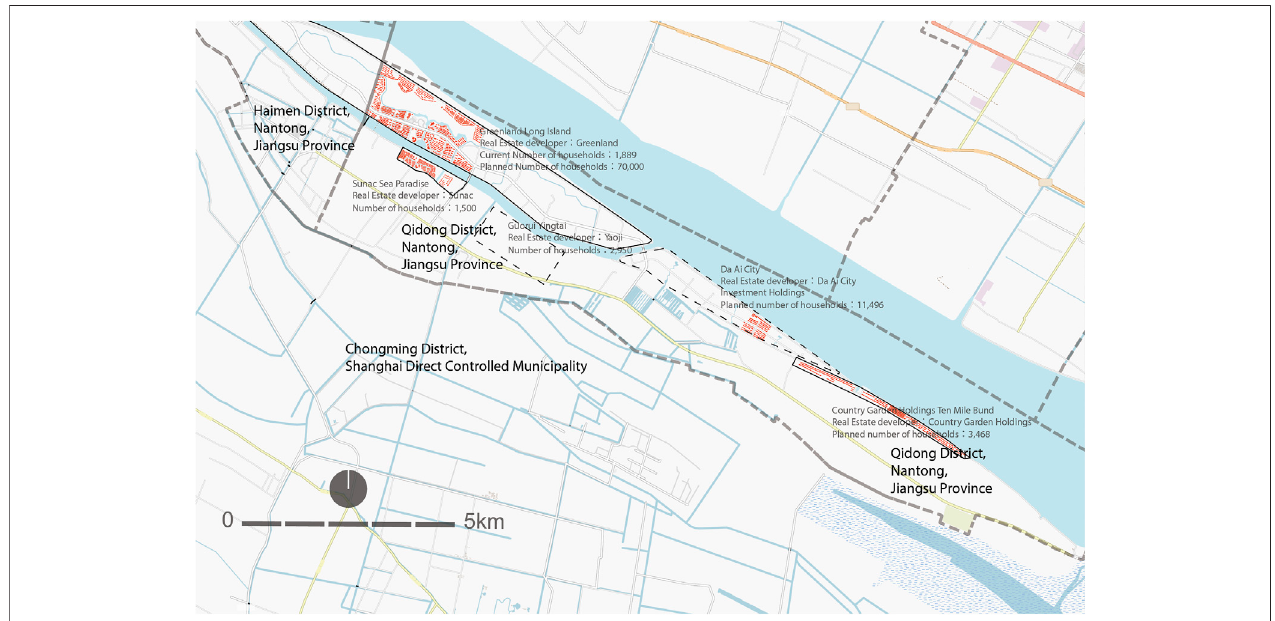
FIGURE 11 | Fragment of the speculative Long Island real estate project in the Jiangsu Province part of Chongming Island (Photo by author, July 2019).